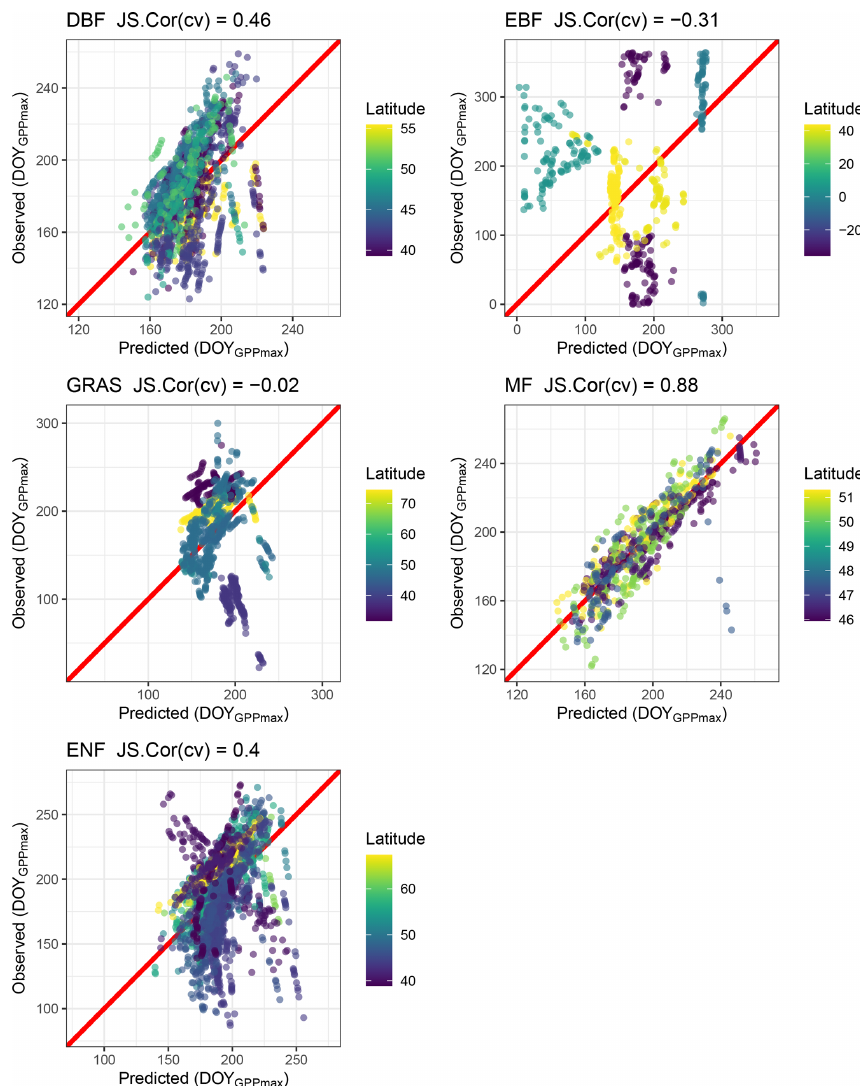
Figure 7. Cross-validation of the circular regression model to predict DOY GPPmax for different vegetation types using air temperature, shortwave incoming radiation, precipitation and vapor pressure deficit (see Methods). Deciduous broadleaf forest (DBF), evergreen broadleaf forest (EBF), grassland (GRA), mixed forest (MF), and evergreen needleleaf forest (ENF). For each vegetation type the Jammalamadaka– Sarma (JS) correlation coefficient is shown in the title of each plot. The red line represents the perfect